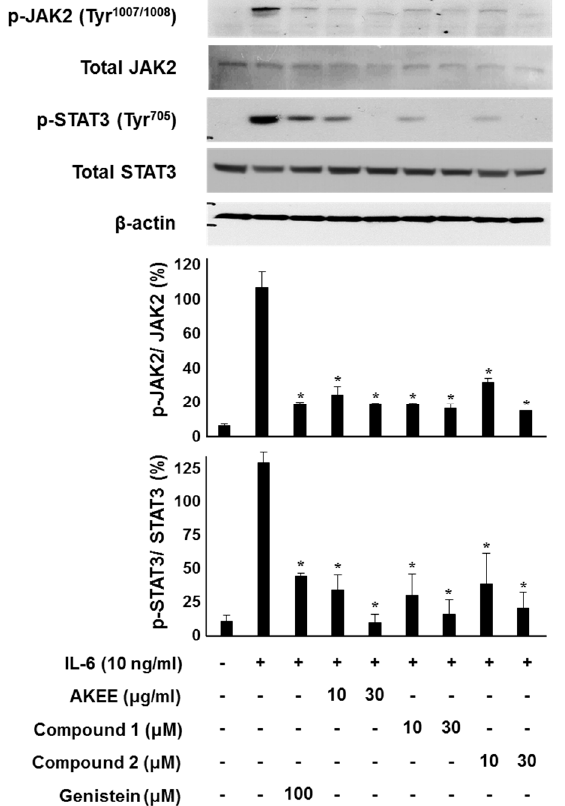
Figure 5. Inhibitory effects of A. katsumadai EtOH extract (AKEE) and its compounds ( 1 and 2 ) on IL-6-induced JAK2 and STAT3 phosphorylation in U266 cells. Cells were pre-treated with samples for 1 h at the indicated concentrations and were then treated with IL-6 (10 ng/mL) for 20 min. Phosphorylated JAK2 and STAT3 was analyzed by Western blotting. The ratios of p-JAK2 or p-STAT3/ β -actin were measured using ImageJ software (1.48v, US National Institutes of Health, Bethesda, MD, USA). The data were analyzed by t -test compared with the IL-6-induced group, and an asterisk (*) indicates significant difference ( p < 0.05).